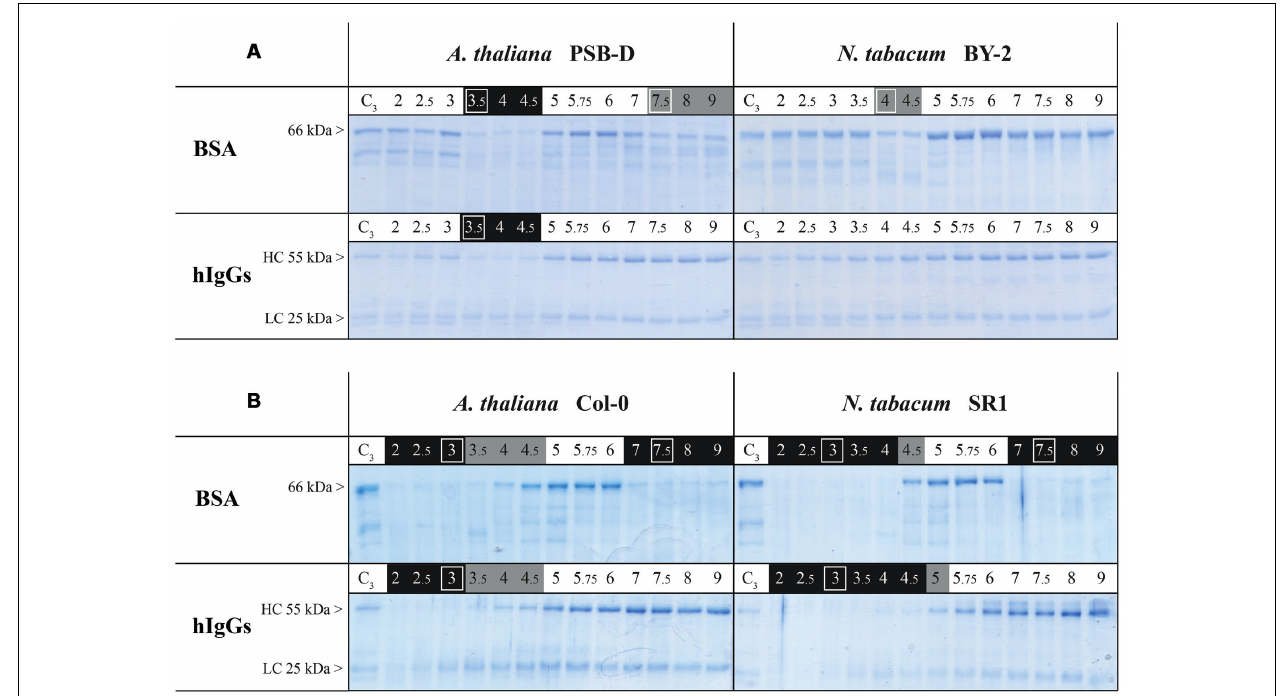
FIGURE 2 | Proteolytic activities in (A) extracellular medium of cell suspensions and (B) rhizosecretome in A. thaliana and N. tabacum . Samples were collected from 7-days-old suspension cells (EM) or 7-weeks-old hydroponic cultures (RZ). 1 μ g of BSA or hIgGs was incubated at 25 ◦ C during 6 h, in a buffer with a pH-value ranging from 2 to 9 and with 5 μ l of secretome. It was then analyzed on reducing SDS-PAGE. C3 indicates control samples incubated at pH 3 after heat-inactivation of secretome proteins and thus shows maximum